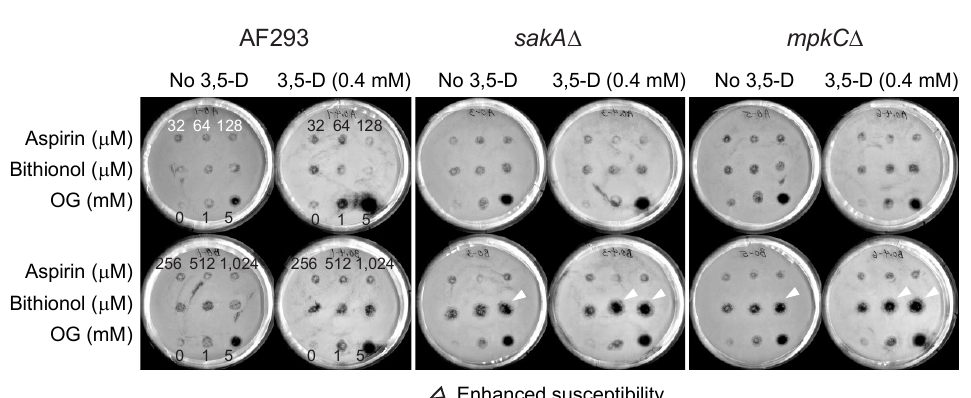
Figure 5. Enhancement of antifungal activity of bithionol by 3,5-dimethoxybenzaldehyde tested in A. fumigatus . 3,5-D, 3,5-dimethoxybenzaldehyde; OG, octyl gallate (positive control).